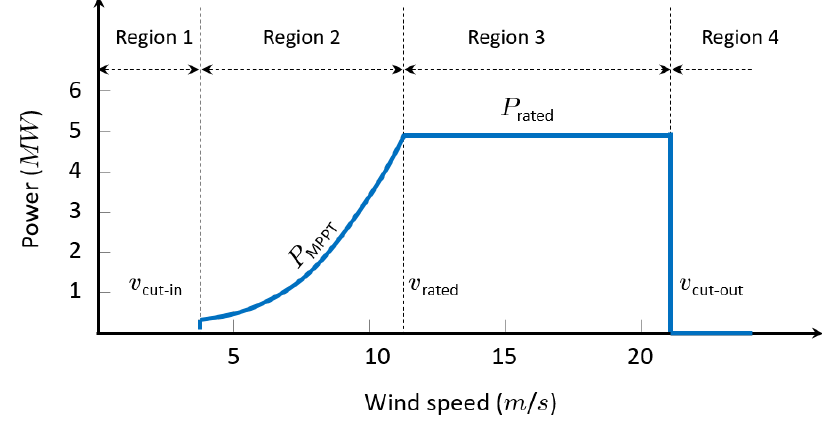
Figure 3. The output power versus wind